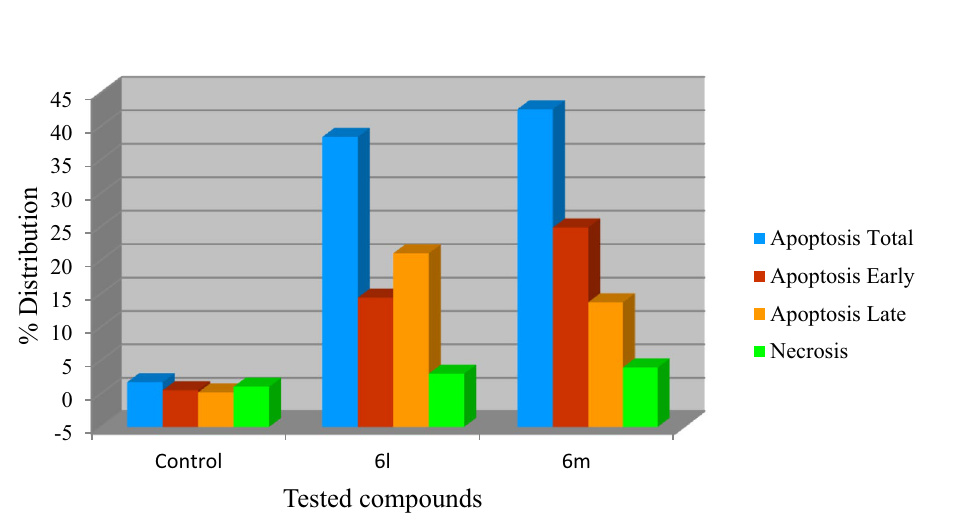
Figure 8. % Apoptosis and necrosis of compounds 6l , 6m and control experiment for MCF7 (breast cancer cell line).